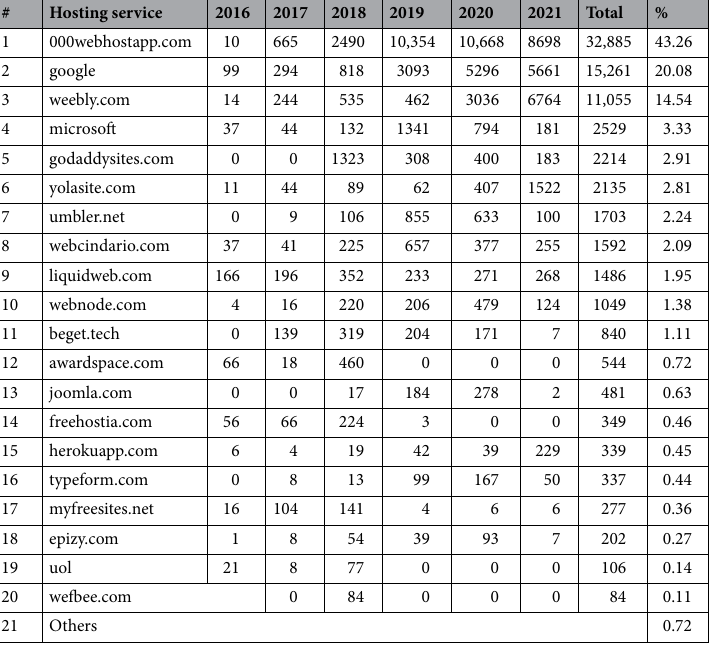
Table 3. Hosting services involved in the evaluation